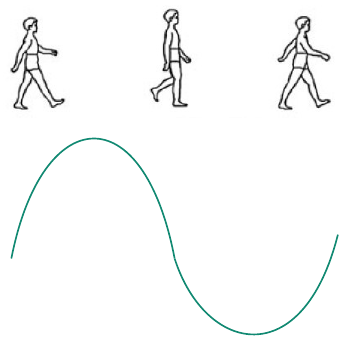
Figure 2. Pedestrian walking